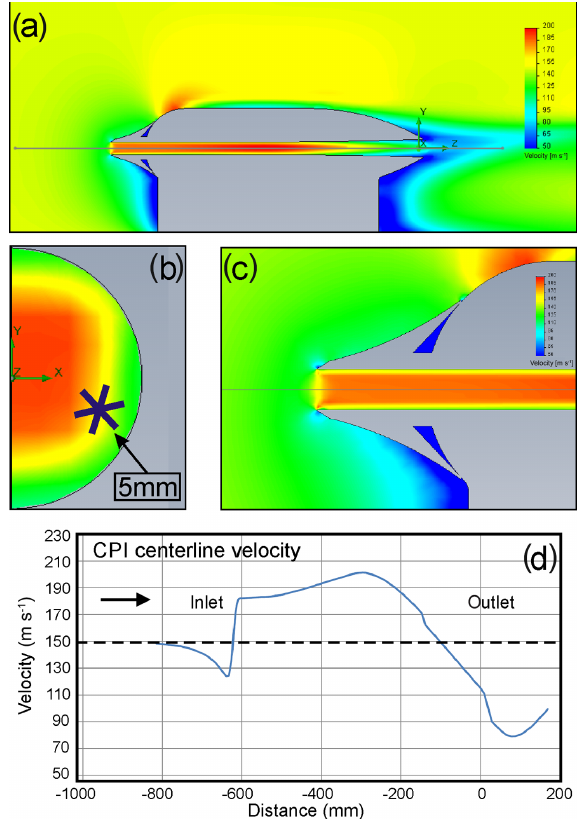
Figure A2. Results of the CFD analysis of flow around and through the CPI sampling tube. (a) Airspeed around the CPI sensor head; (b) cross section of speed inside the CPI inlet tube at the location of the sample volume; (c) zoomed CPI inlet area as in panel (a) ; (d) changes of the air velocity along the CPI inlet tube centerline. The simulation was performed for P = 450mbar, T a = − 40 ◦ C, TAS = 150ms − 1